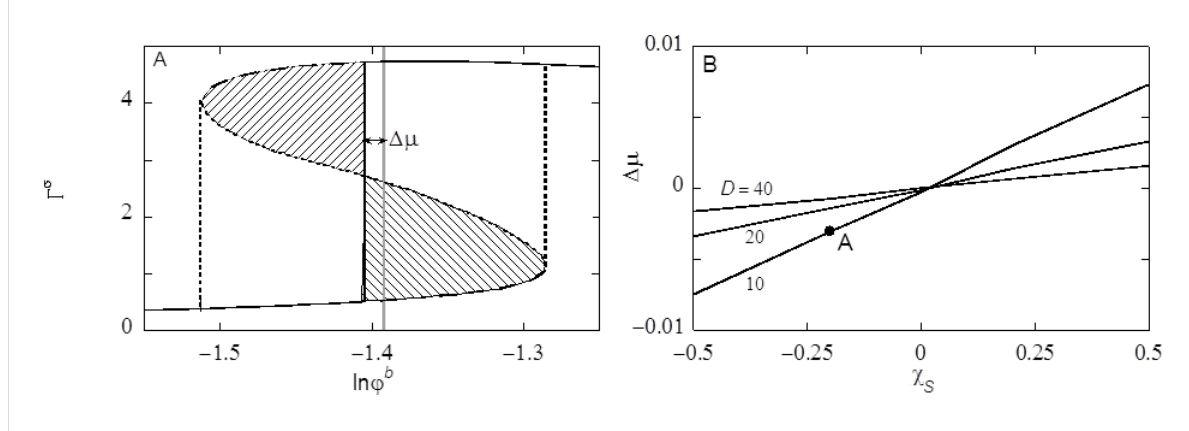
Figure 5: A) Adsorption amount Γ σ of the liquid component as a function of the volume fraction of liquid in the vapour φ b in lin–ln coordinates ( x -axis is chemical potential), in a slit with surfaces that are a distance D = 10 apart and have an adsorption energy χ S = − 0.2. The metastable branches are dashed. The unstable part is dotted. The chemical potential µ # is indicated as the grey vertical line. The solid vertical line is placed at the chemical potential where a step in the isotherm takes place (local binodal). This step is found by the Maxwell construction, that is by the equal area argument (the two shaded regions have the same area). The difference in chemical potential Δ µ between the place of the step and the binodal is indicated. The vertical dotted lines are placed at chemical potentials corresponding to the spinodal points. B) The chemical potential where the step in the isotherm (compared to value of the bulk binodal) Δ µ takes place (at equilibrium) as function of χ S for slit distances D =10, 20 and 40 as indicated. The solvent–vacancy interaction is set to χ = 2.2. The label A on the curve for D = 10 corresponds to the condition used in panel A.